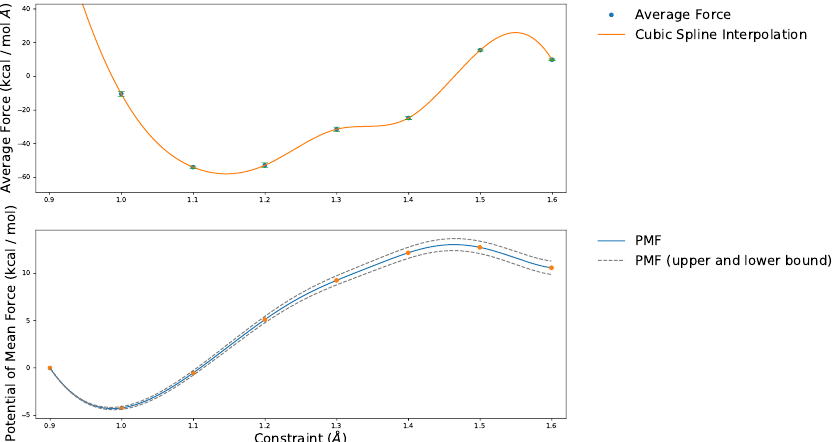
Figure 4. Determination of R c from simulation of water, by fitting to the experimental value. The simulations were carried out in a cubic box with a side length of 15.6406 Å.